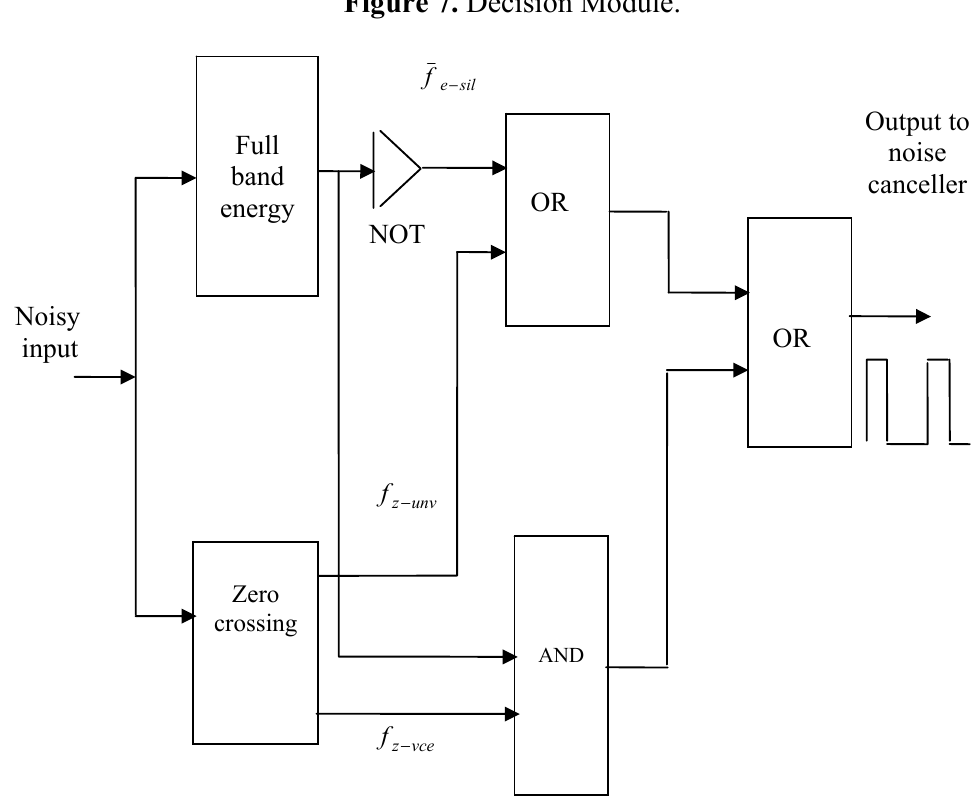
Figure 7. Decision